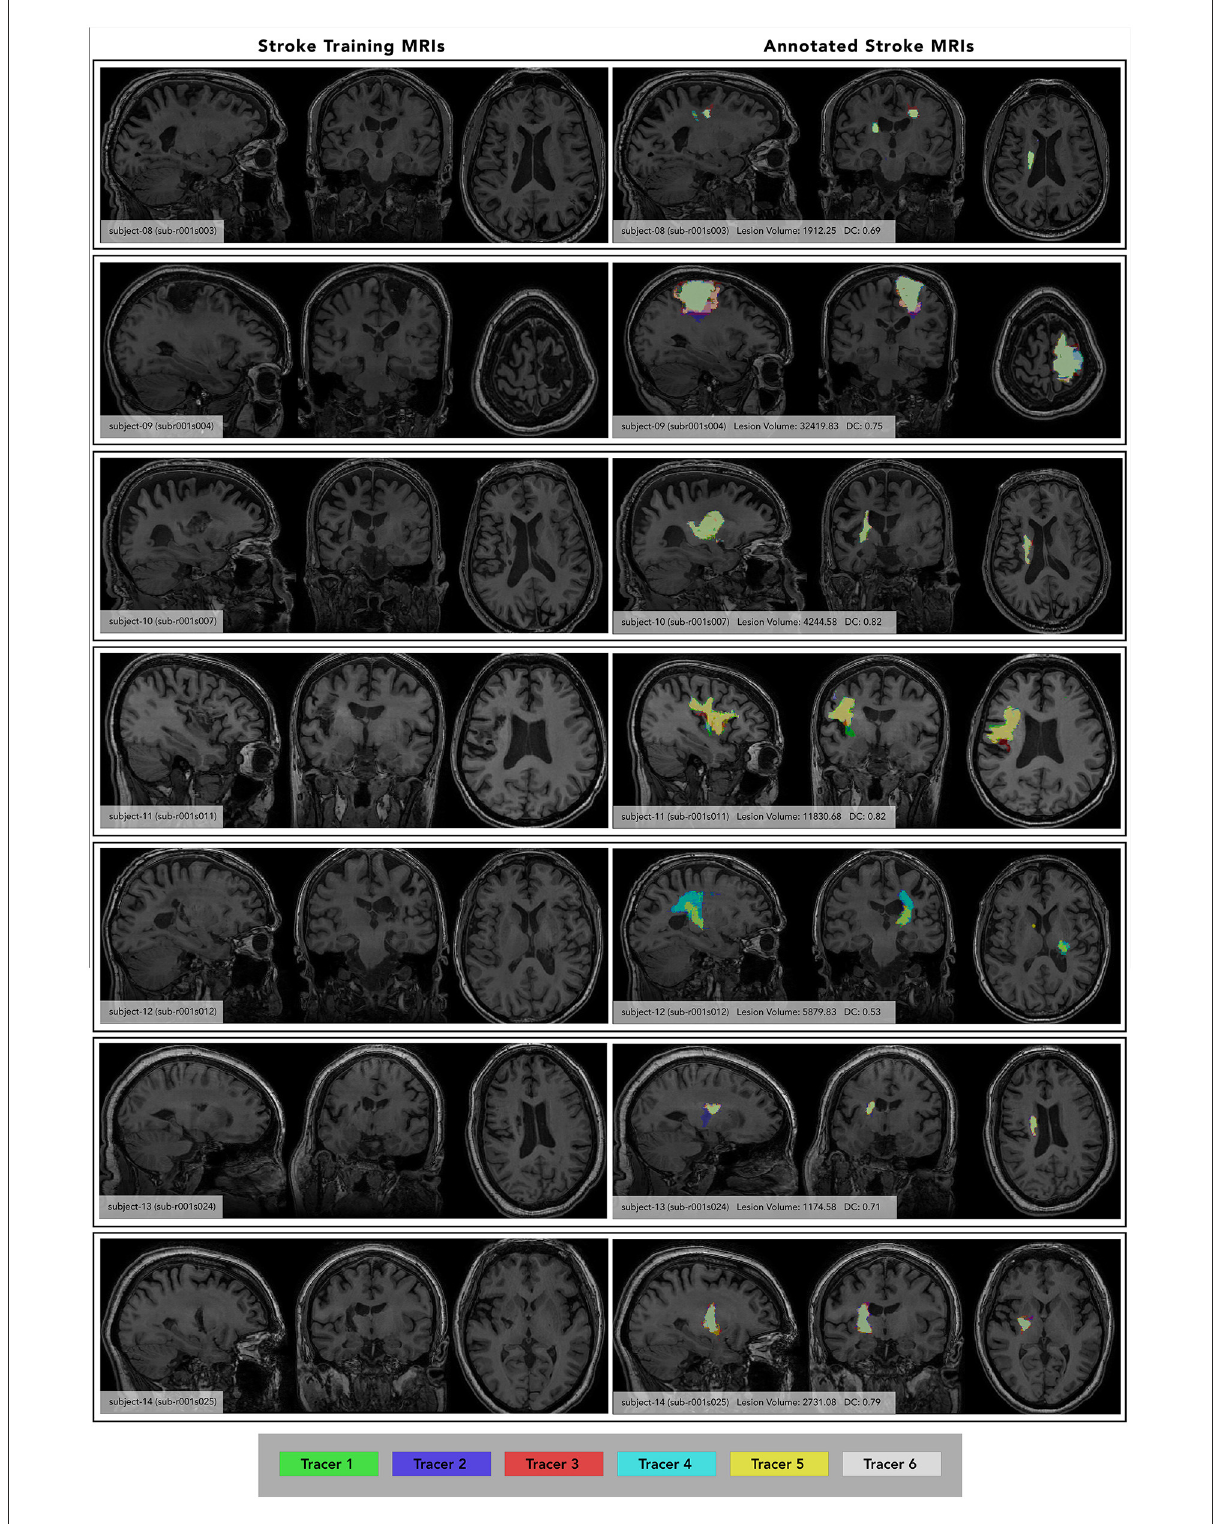
FIGURE3 Individual Subject Stroke Lesions with and without lesion masks. (Left) images of each subject at maximum lesion width, with subject number